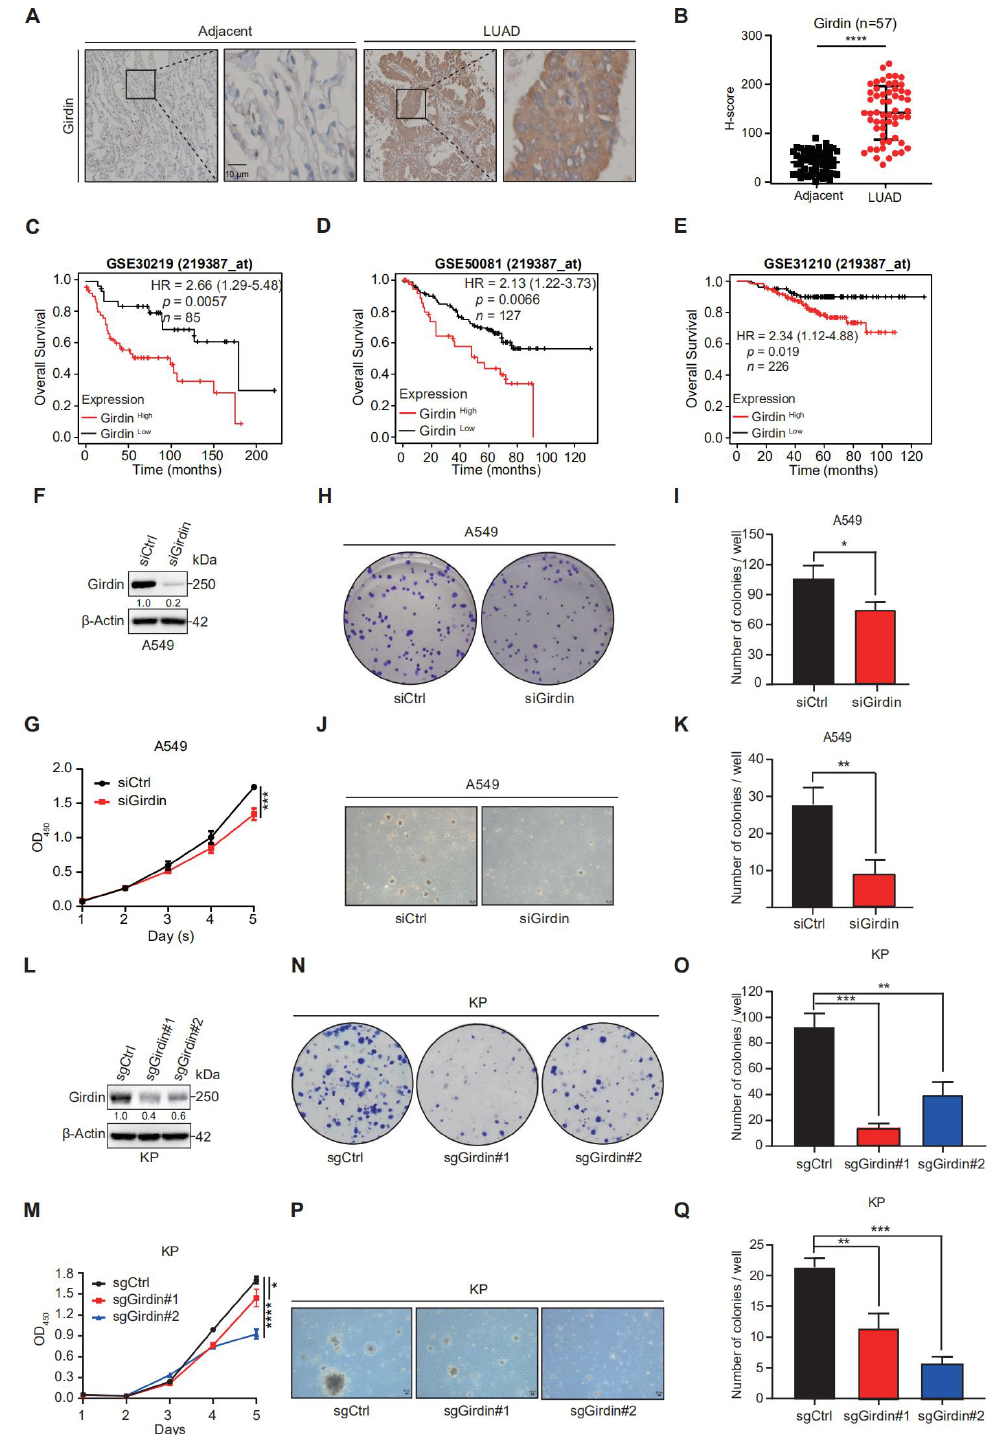
Figure 2. Girdin ablation inhibits cell proliferation in LUAD. ( A , B ) IHC staining and statistical analysis of Girdin in human LUAD tissue. Scale bar, 10 µ m. n = 57. Data are shown as mean ± SEM (**** p < 0.0001). ( C – E ) Kaplan–Meier analysis of overall survival was performed based on Girdin expression. GSE 30,219, GSE 50,081, and GSE 31,210 are from the Gene Expression Omnibus (GEO) database. ( F ) A549 cells were transfected with siCtrl or siGirdin for 72 h and immunoblotted as shown. ( G ) Effects of siCtrl and siGirdin on cell proliferation were determined by using CCK8 assays with the A549 stable cell line. Data are shown as mean ± SEM (*** p < 0.001). ( H , I ) Representative images and statistical results of siCtrl and siGirdin for colony formation in the A549 cell line. Data are